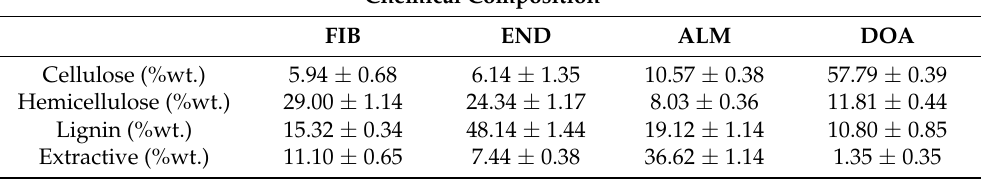
Table 1. Proximate analysis results and cellulose, hemicellulose, and lignin composition for the buti á precursors. Proximate Analysis * FIB END ALM DOA Moisture (%wt.) Fixed carbon (%wt.) Volatile matter (%wt.) Chemical Composition * FIB END ALM DOA Cellulose (%wt.) Hemicellulose